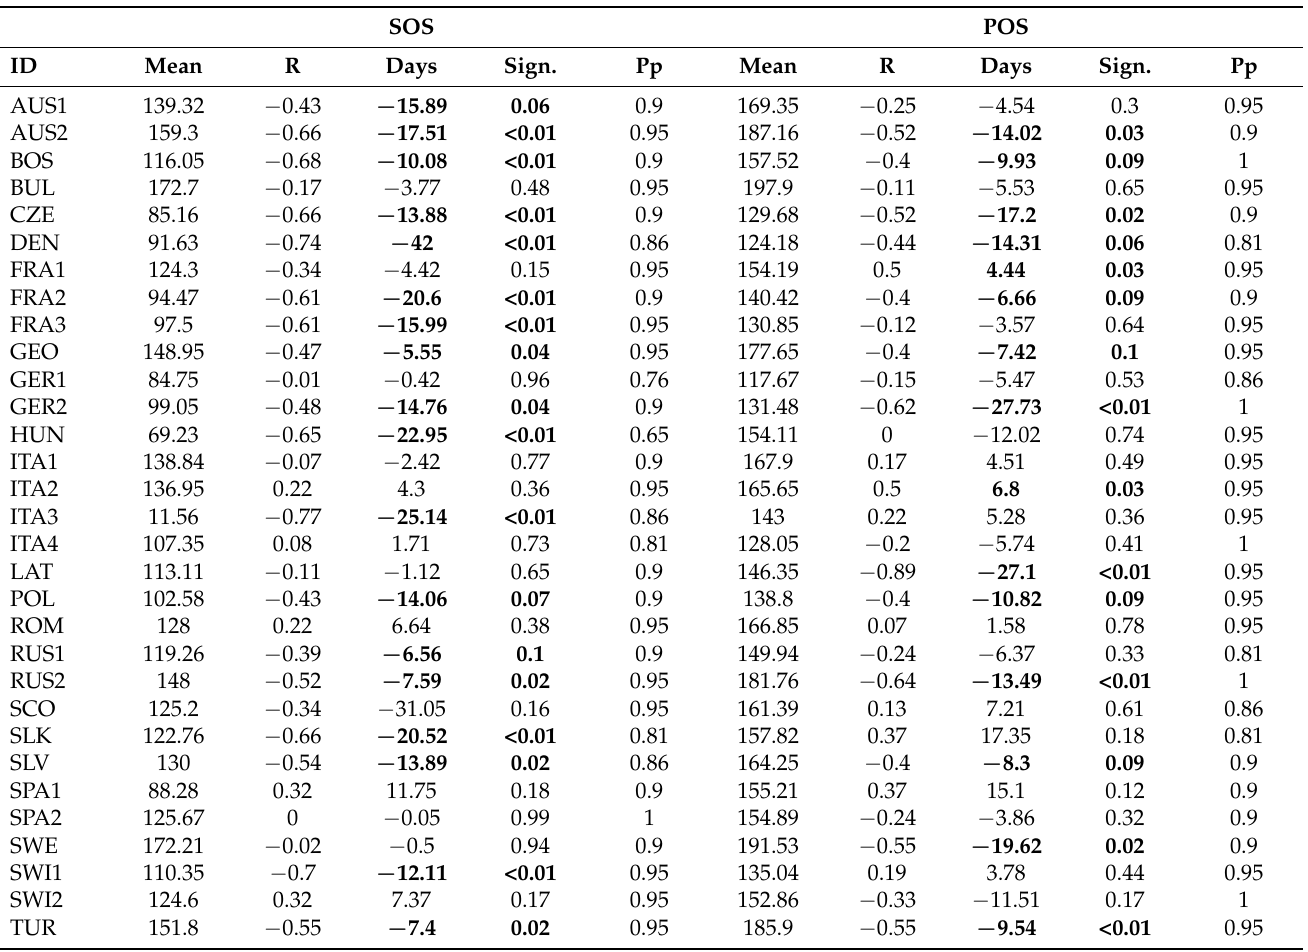
Table 4. Results of SOS and POS analysis over the period 2001–2021. Mean represents the mean value of SOS and POS during the period 2001–2021, reported to give general information about each site (data not included in the analysis). R columns show the correlation coefficient (R) between phenological dates (i.e., SOS and POS) and years, Sign . the significance (F) of the SOS and POS-years regression, and Days the difference between SOS and POS in the years 2001 and 2021 according to the equation found with the linear regression.